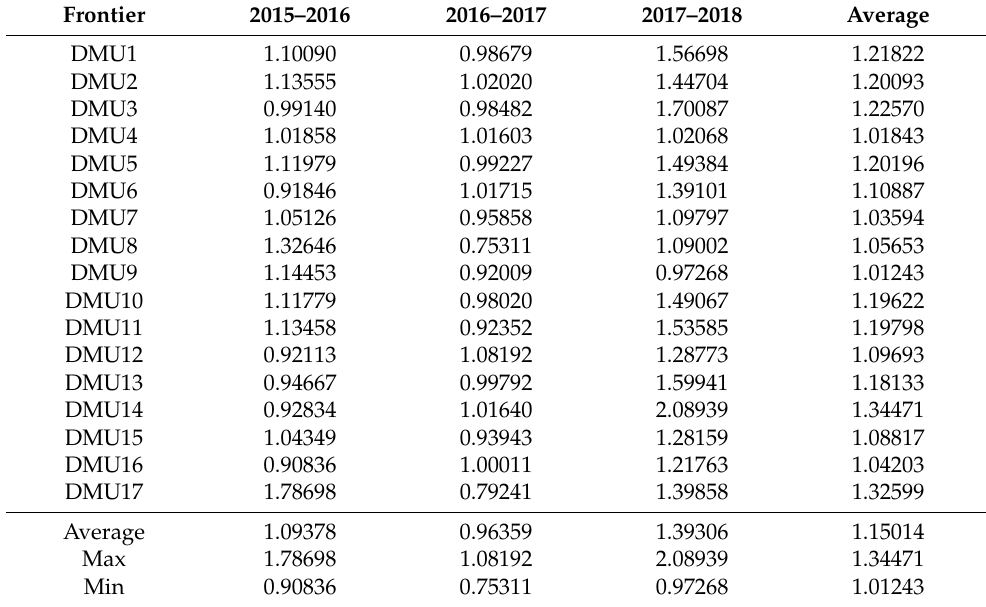
Table 7. Frontier-shift index (technological change).